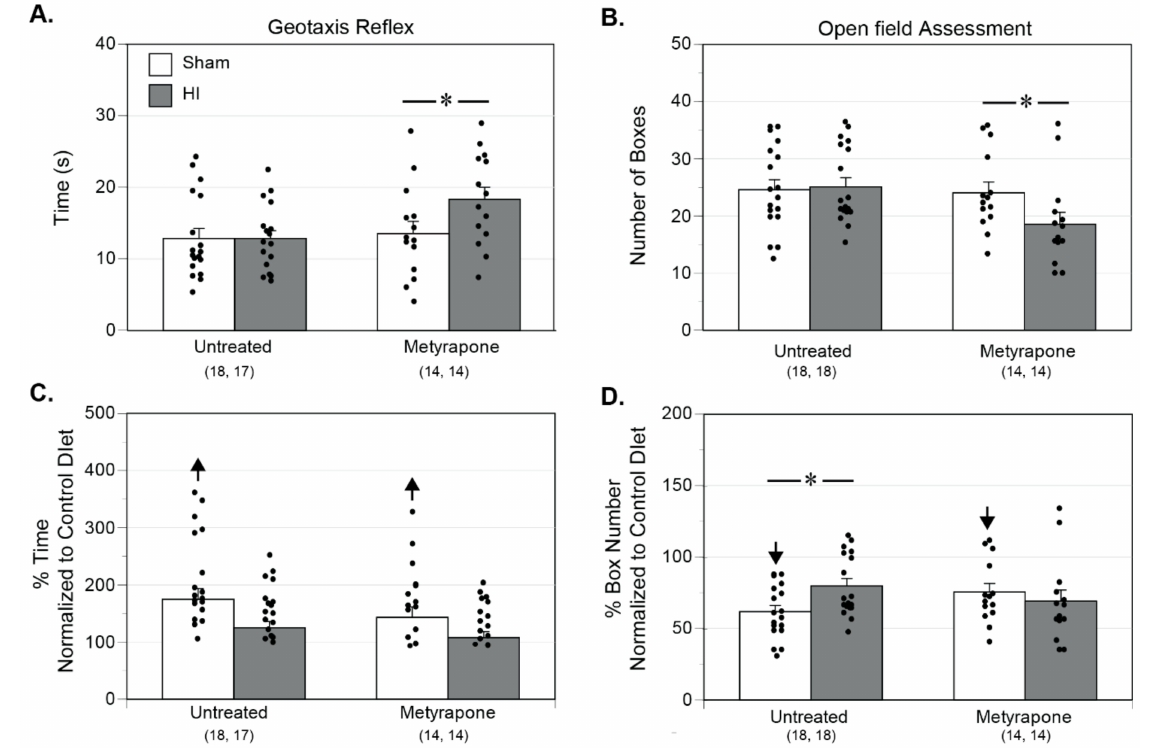
Figure 10. Effects of HI, gestational MET, and MUN on neurobehavioral measures in P11/P12 pups. Neurobehavioral assessments conducted in neonatal MUN rats examined the geotaxis response ( A , C ) and open-field exploration ( B , D ). ( A , B ) Columns and error bars indicate SEM overlaid with a dot plot of individual values and show difference between MUN groups. ( C , D ) Columns and error bars indicate MUN values normalized to CD for each response and show MUN-induced effects. ANOVA with a post-hoc Fisher’s LSD determined the statistical significance as shown by: * for differences between Sham and HI groups. Refer to Figure 4 for a description of the statistical symbols and n values shown